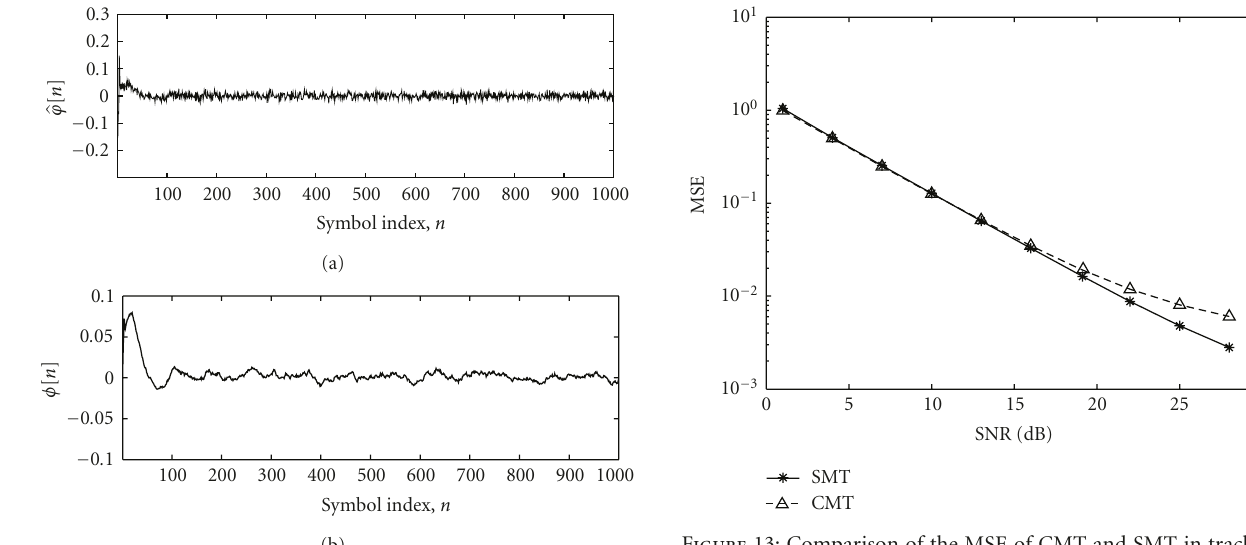
Figure 13: Comparison of the MSE of CMT and SMT in tracking